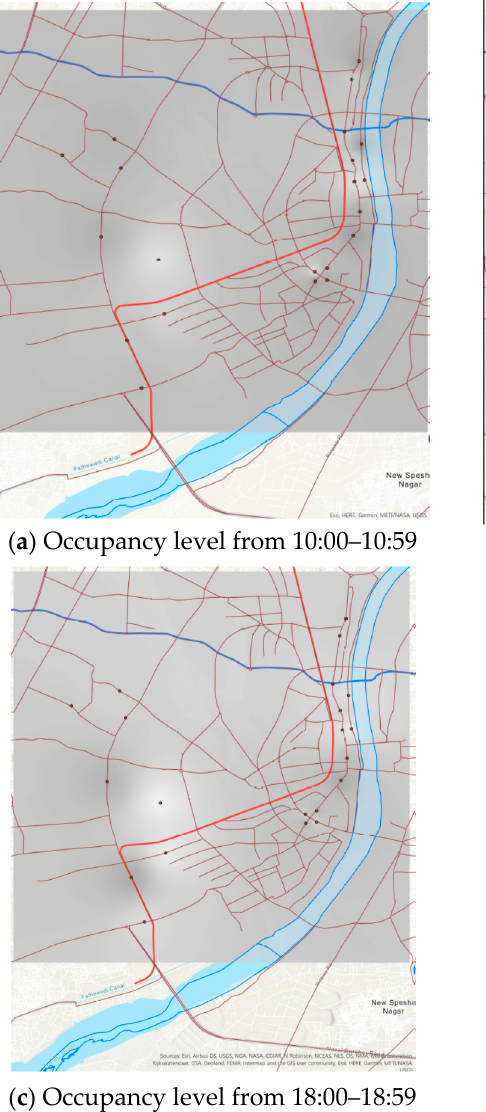
Figure 10. Spatial congestion analysis for different time frames.